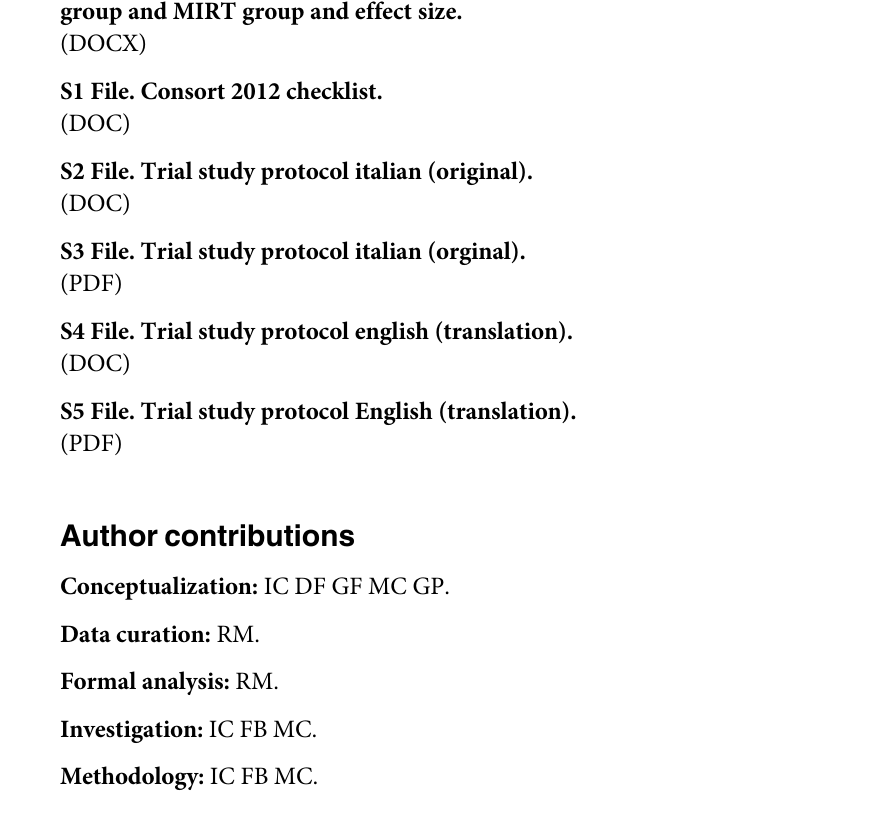
S1 Table. Demographic and clinical characteristics of patients assigned to MIRT group and MIRT-Lokomat group. S2 Table. Baseline and end of treatment values of outcome variables for both groups of patients. S3 Table. Difference (discharge-admission) of the outcome variables for MIRT+Lokomat group and MIRT group and effect